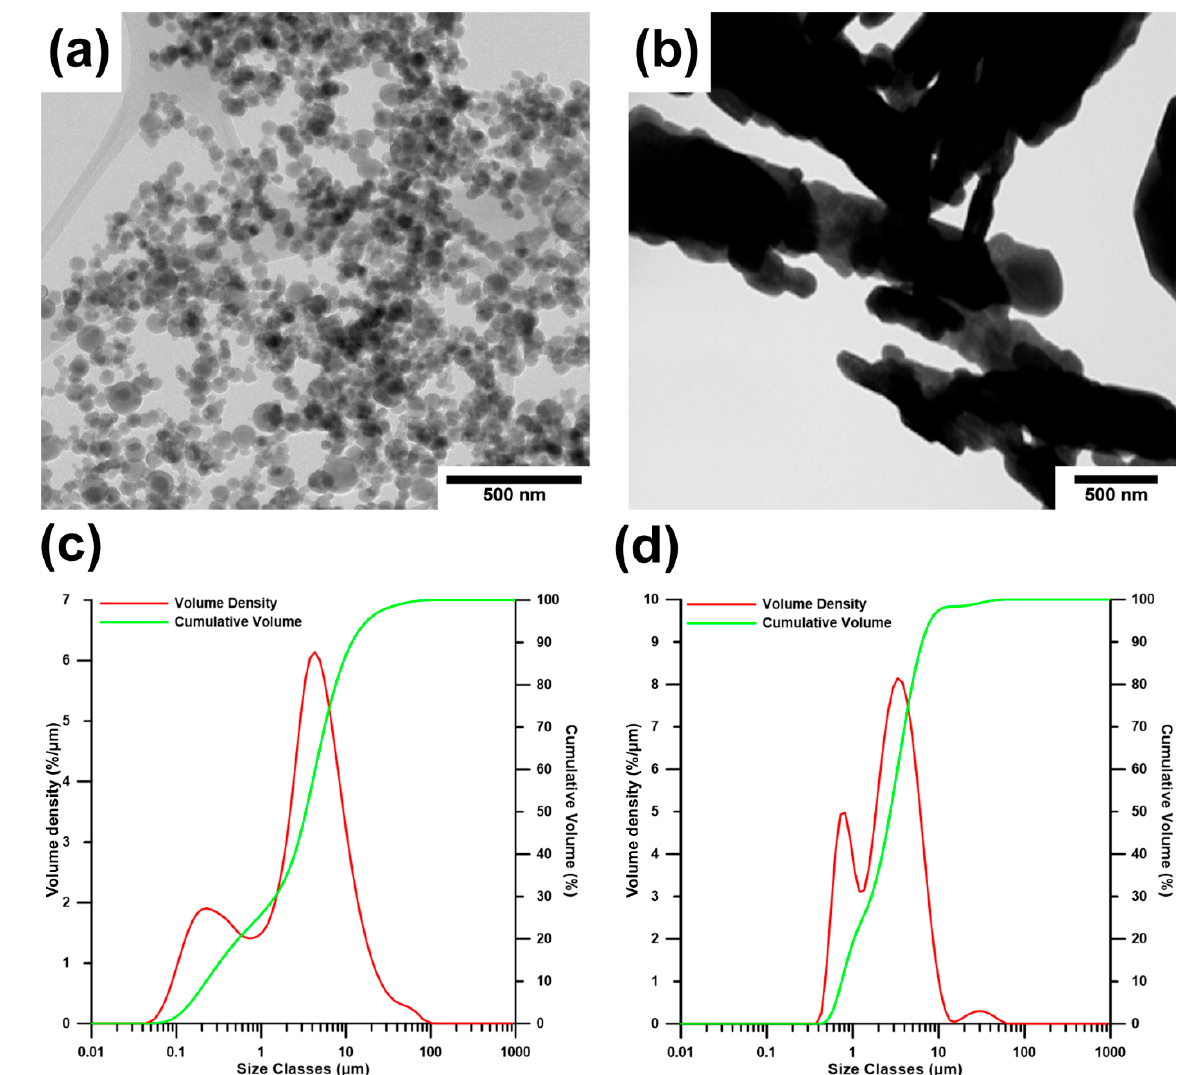
Figure 1. The morphology and distribution curves of ( a , c ) HA and ( b , d ) MO particles.